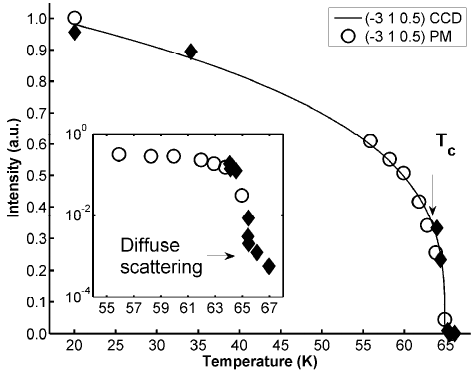
Figure 7. Temperature evolution of the superstructure reflection intensity in DMTTF-CA measured by X-ray scattering. The insert shows the intensity measured at maximum with a high-resolution.